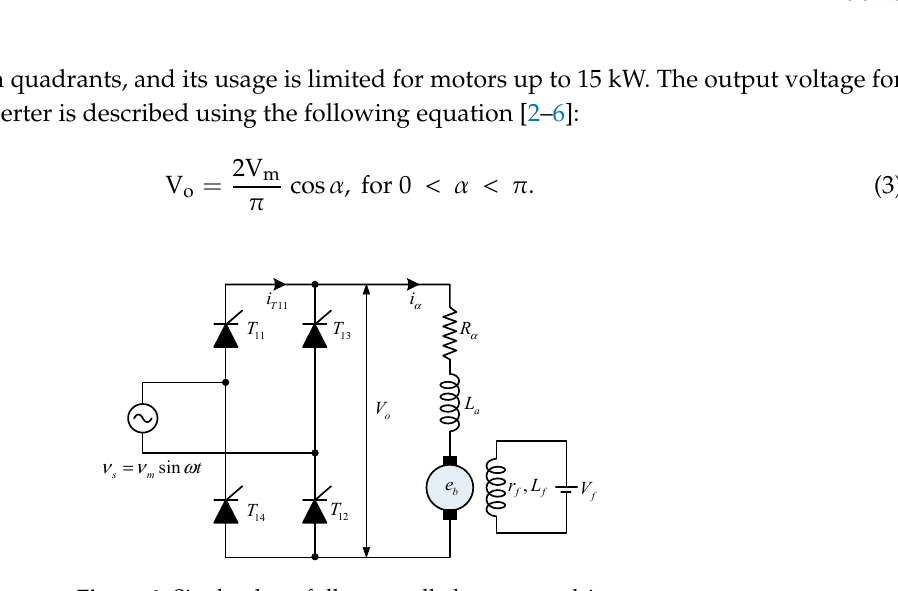
Figure 6. Single-phase fully-controlled converter drive.